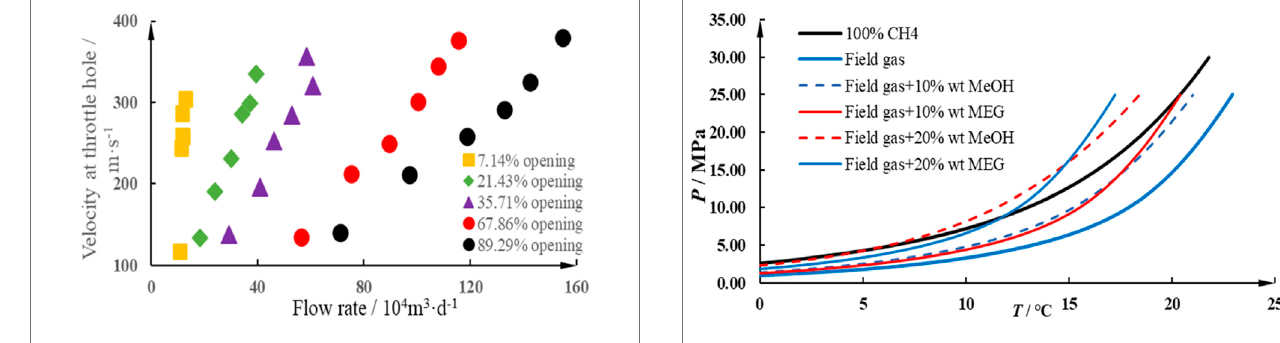
FIGURE 13 | Phase equilibrium curves of hydrate formation in different